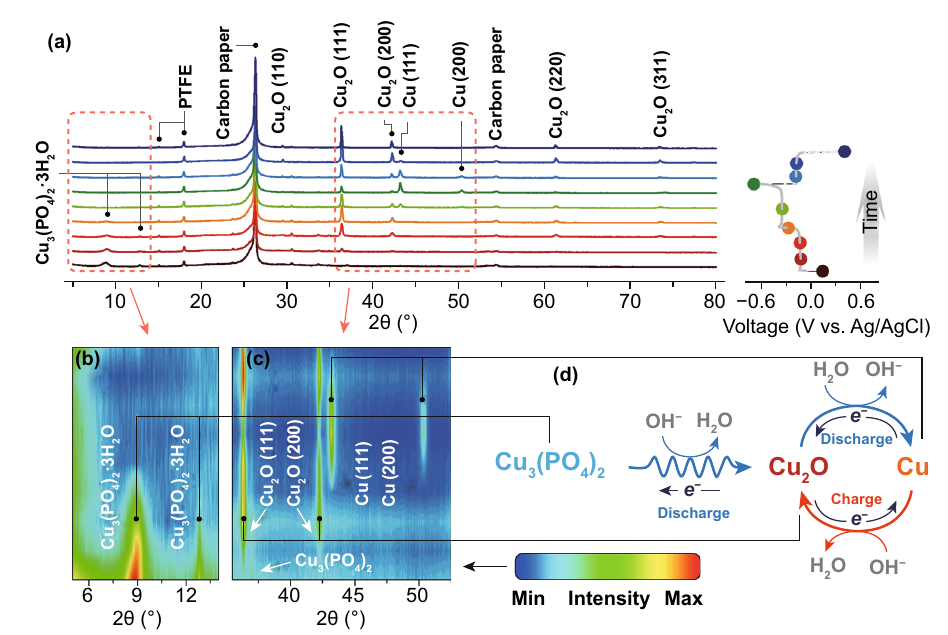
Fig. 2 a XRD patterns of Cu 3 (PO 4 ) 2 electrode during cycling. The contour map for the corresponding XRD patterns in the 2 θ range of b 5–14° and c 35.5–52.5°. d Reasonable mechanism for Cu 3 (PO 4 ) 2 electrode during the electrochemical